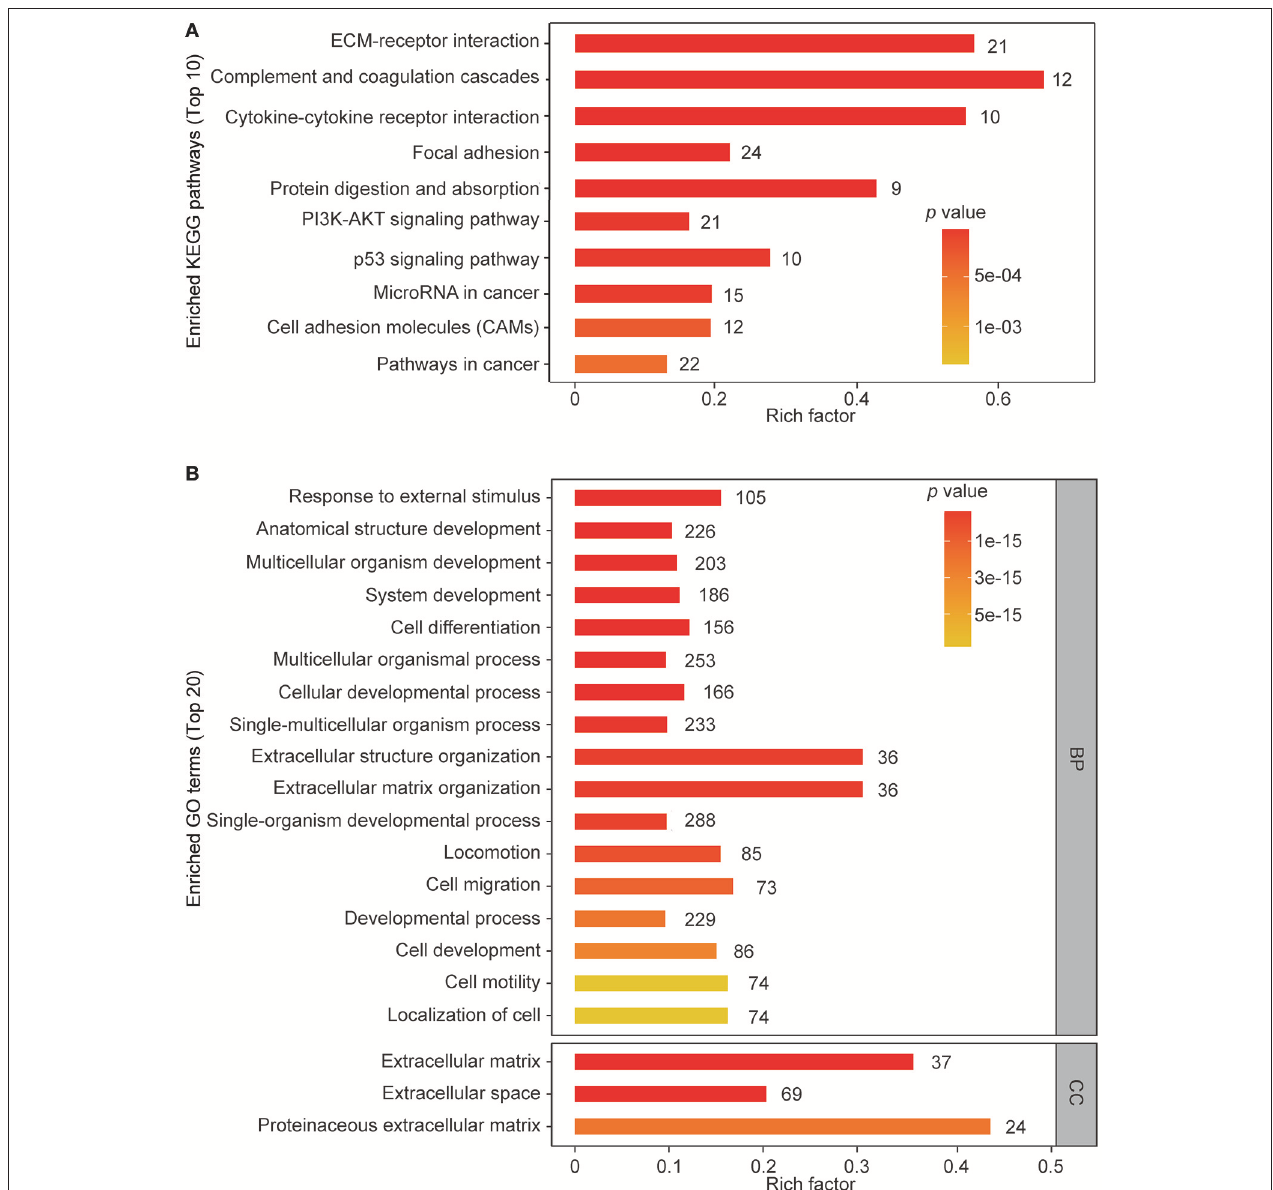
FIGURE 3 | KEGG pathway enrichment and GO terms enrichment of differentially expressed proteins in ZIKV-infected NPCs. KEGG pathway enrichment analysis (A) and GO terms enrichment analysis (B) were applied based on the Fisher’ exact test, considering the entire quantified protein annotations as the background dataset. Benjamini-Hochberg correction for multiple testing was further applied to adjust derived p -values. Only functional categories and pathways with p -values under a threshold of 0.05 were considered as significant. Numbers of quantified proteins in each enriched pathway or GO term are indicated to the right of the